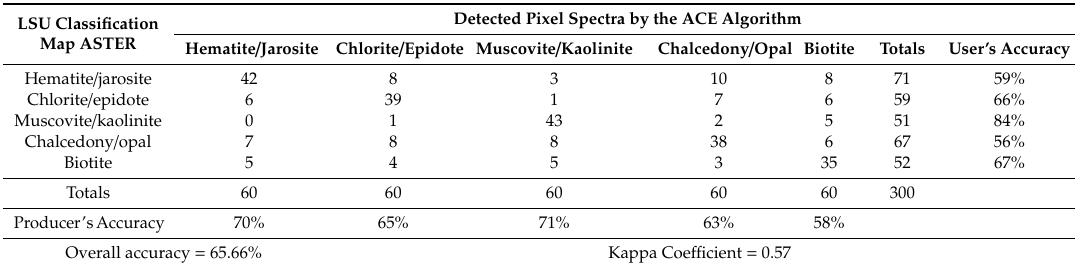
Table 7. Confusion matrix for the LSU classification image-maps derived from ASTER versus the ACE fraction images derived from VINR + SWIR bands of ASTER.